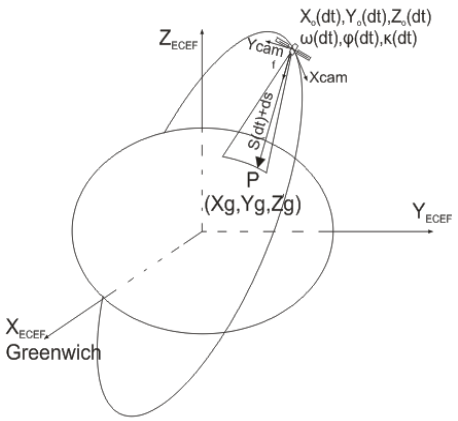
Figure 1. Relation between ECEF and the camera’s